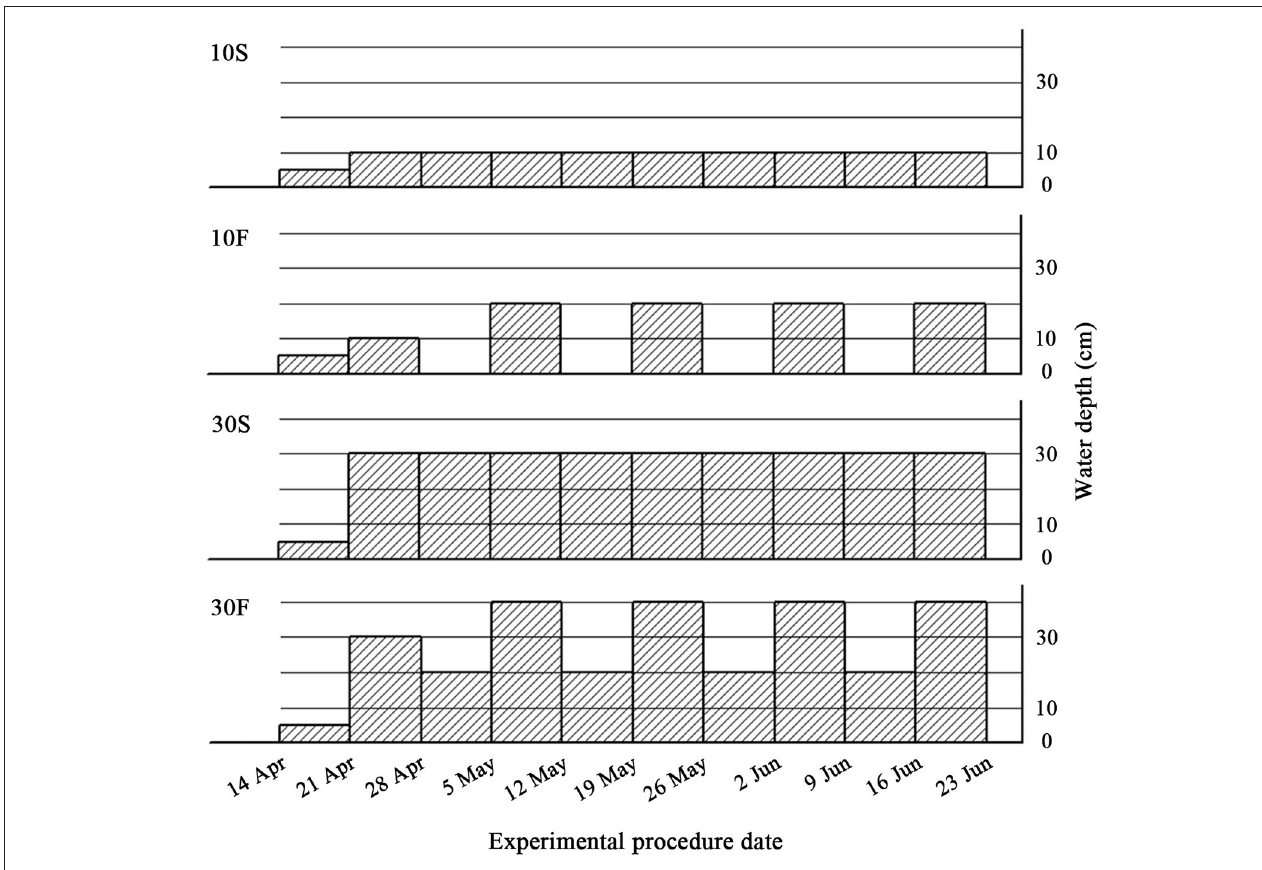
FIGURE 1 | Experimental design. Schematic representation of the four hydrological treatments. 10S, static water level at 10cm; 10F, water depth fluctuating from 10cm with a 10cm amplitude; 30S, static water level at 30cm; 30F, water depth fluctuating from 30cm with a 10cm amplitude. The shaded areas indicate the water depth, and abscissae indicate the date of the experiment in 2016. The first two weeks, from 14 April to 28 April, constituted a pretreatment stage, and the treatments lasted for 8 weeks, until 23 June